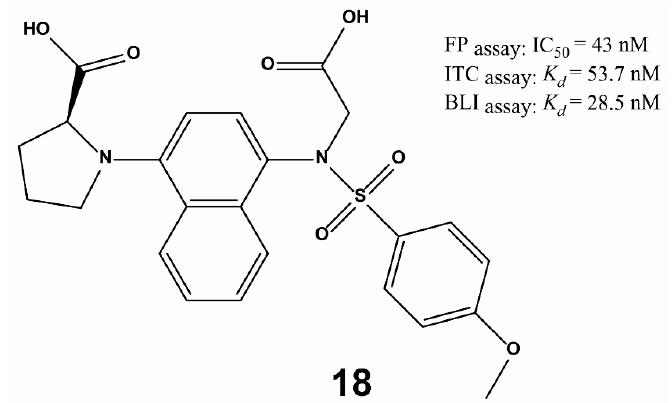
Figure 12. Structure of compound 18 . FP = fluorescence polarization; K d = equilibrium dissociation